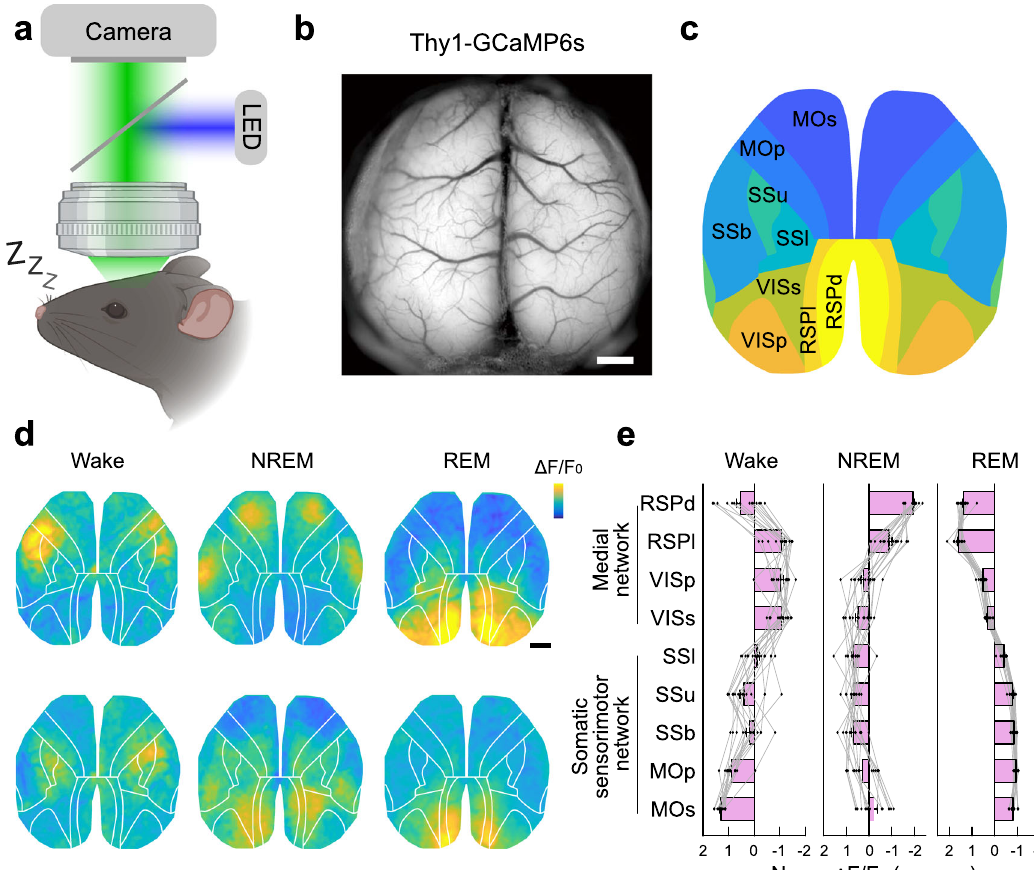
Fig.1|MesoscaleCa 2+ imagingofthedorsalcortexduringthesleep-wakecycle. a Schematic diagram depicting the mesoscale Ca 2+ imaging from head- fi xed mice. b Example fi eld-of-view (time-averaged) of the dorsal cortex imaged through the transparent skull of a Thy1-GCaMP6s mouse. Scale, 1mm. c Cortex atlas for align- ment. MOs secondary motor cortex, MOp primary motor cortex, SSb somatosen- sorycortex,barrel fi eld,SSusomatosensorycortex,upperlimb,SSlsomatosensory cortex, lowerlimb, VISpprimary visual cortex,VISsassociationvisualcortex, RSPd